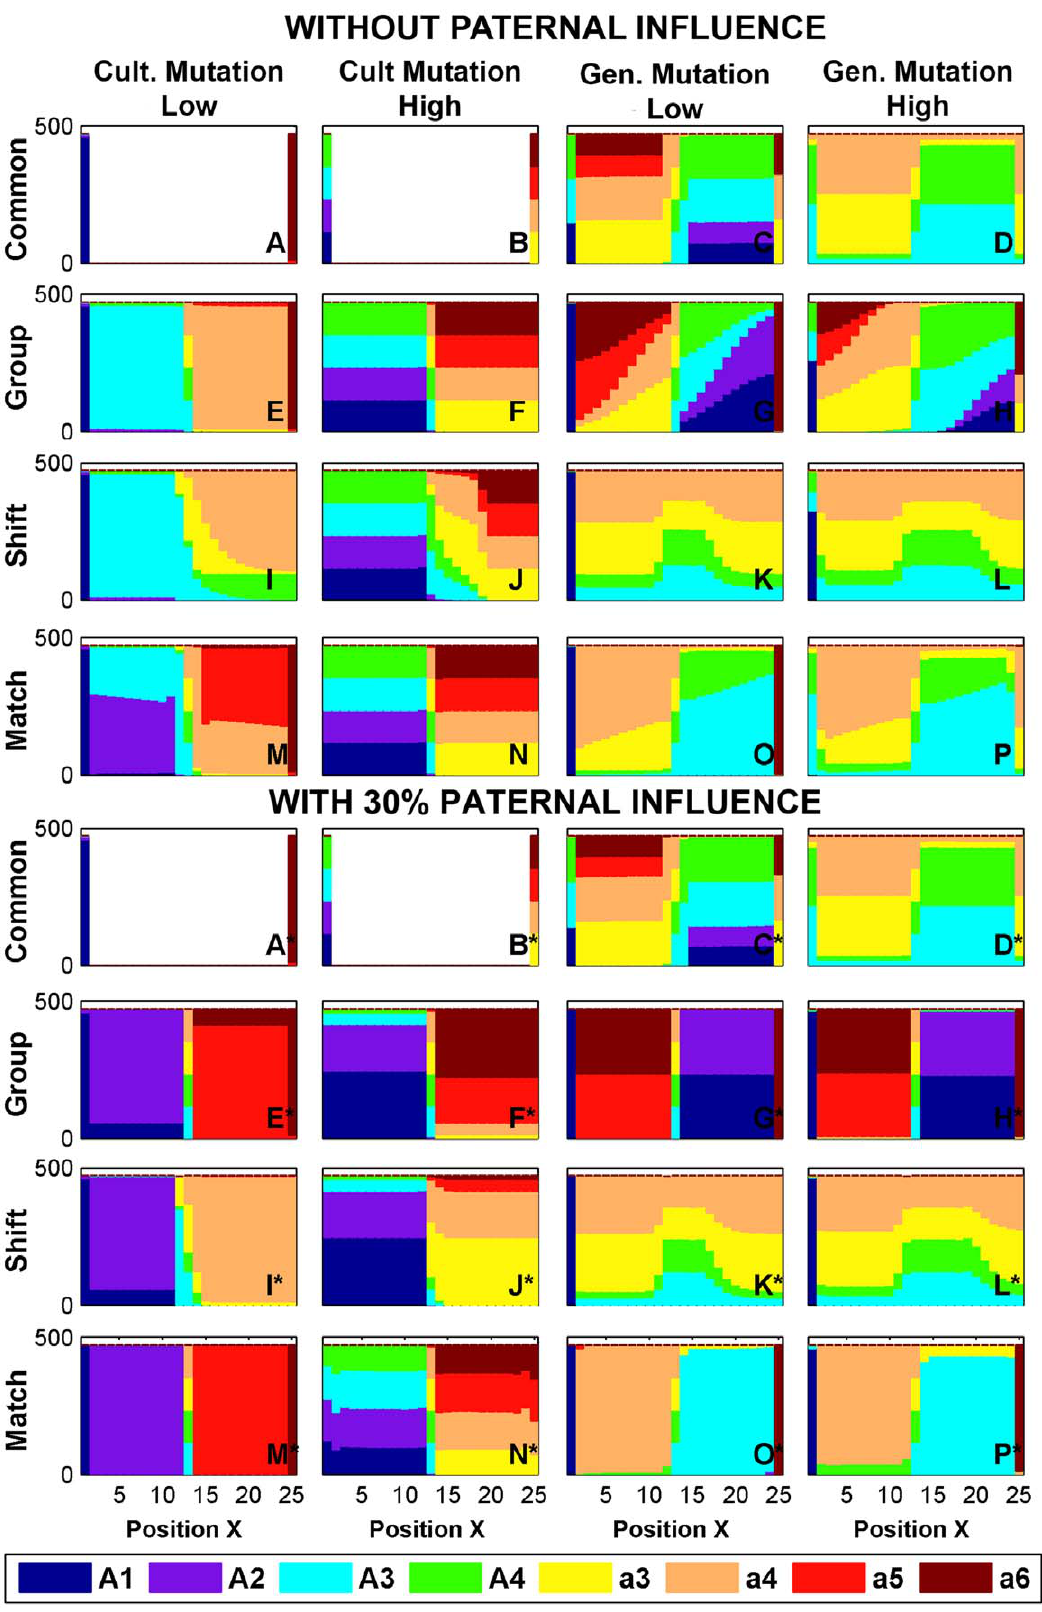
Figure 5. Area III under cultural or genetic mutations. Plots are as in Figure 4, but with parameters v 1 =10 2 4 , v 2 =10 2 4 .